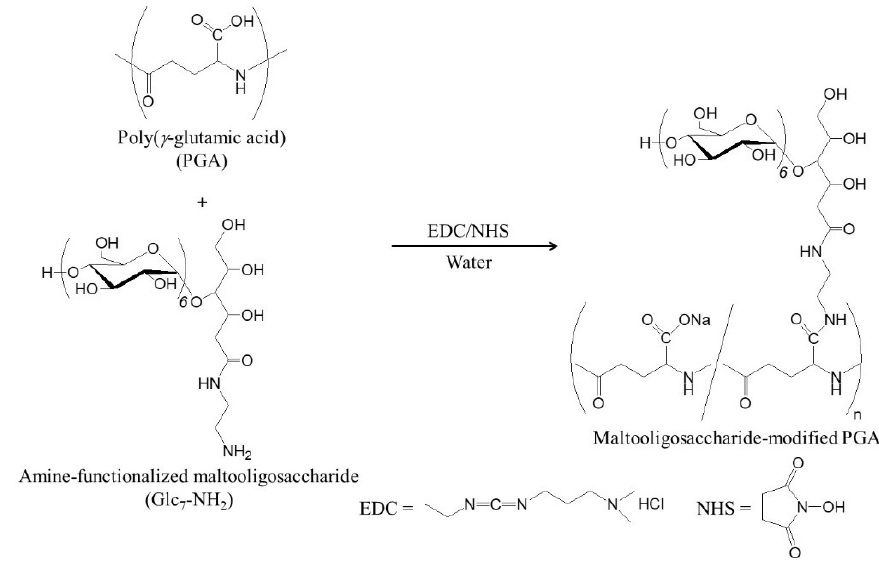
Figure 1. Synthesis of maltooligosaccharide-modified PGA.